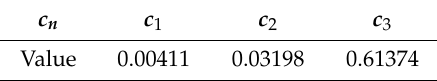
Figure 11. The relationship between 𝑚(𝜀) and 𝜀 at a strain rate of 1300 s ⁻ 1 and different temperatures. Table 7. Experimental constants in m ( ε )